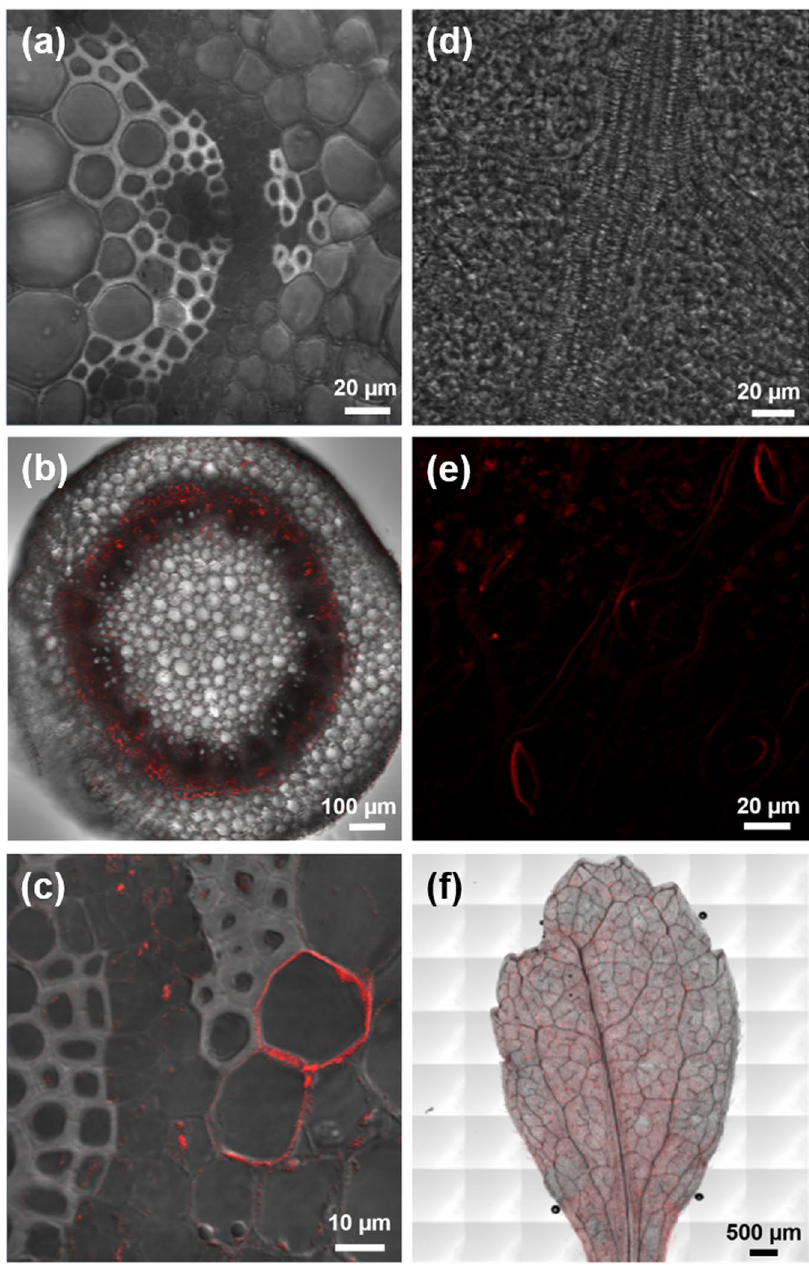
Figure 6. Identification of fluorescence by a multiphoton microscope at specific points on the stem and stevia leaf. ( a ) Vascular beams of the control treatment, ( b ) cross-section scan of stem with 100 mg L − 1 , ( c ) presence of silver in cells with 50 mg L − 1 , ( d ) leaf rib control, ( e ) fluorescence on stomatas at 25 mg L − 1 ( f ) fluorescence in leaf at 200 mg L − 1